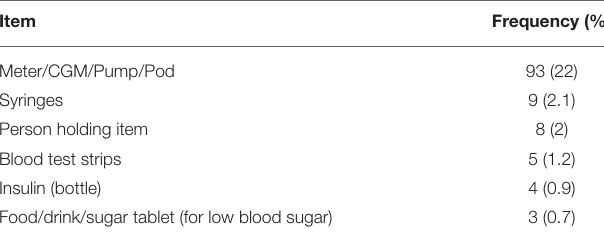
TABLE 2 | Diabetes self-management items in sample posts 107 posts (25.3%) contained devices; multiple devices could be in the same post ( N = 423).